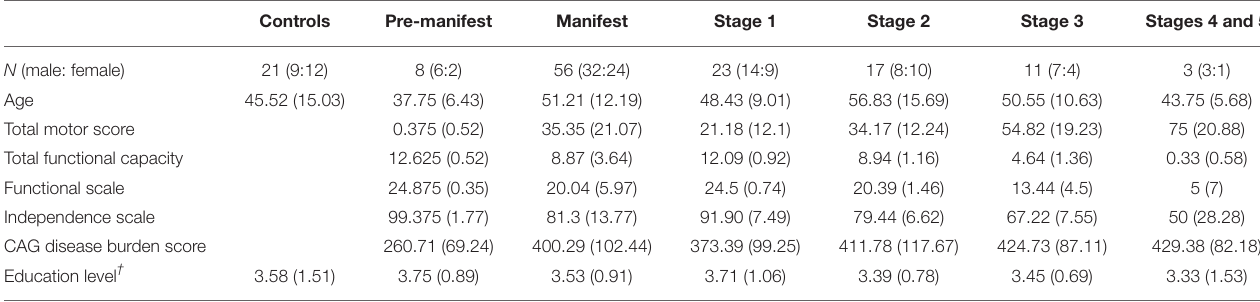
TABLE 2 | Mean MBT participant demographic and clinical information revealed manifest subjects were significantly older than pre-manifest subjects, and stage 2 subjects were significantly older than healthy controls. Controls Pre-manifest Manifest Stage 1 Stage 2 Stage 3 Stages 4 and